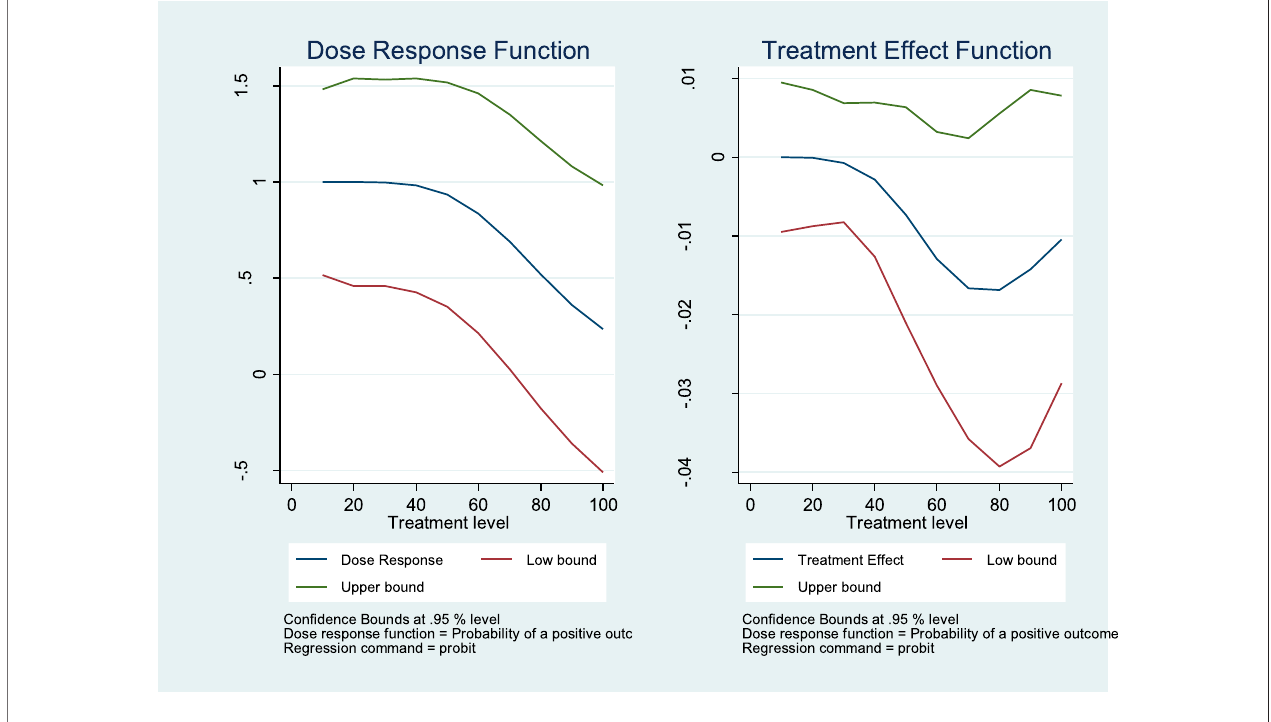
FIGURE 5 | Does-response and treatment effect of EV purchase probability without class.